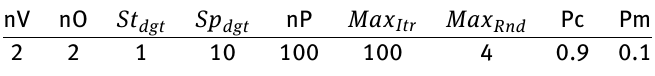
Table 1: VSSCGA Settings for Effati and Nazemi example